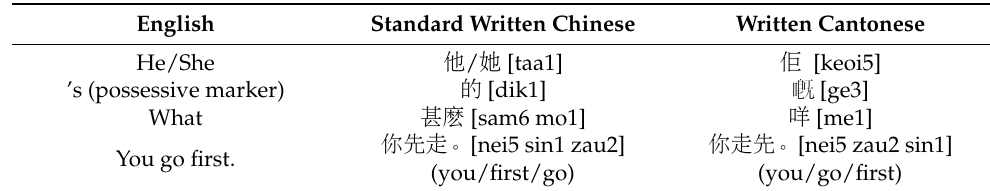
Table 1. Examples of the differences between Standard Written Chinese and Written Cantonese. Romanisation is performed with Jyutping by the Linguistic Society of Hong Kong and the written form of Cantonese follows the most adopted one in Hong Kong. English Standard Written Chinese Written